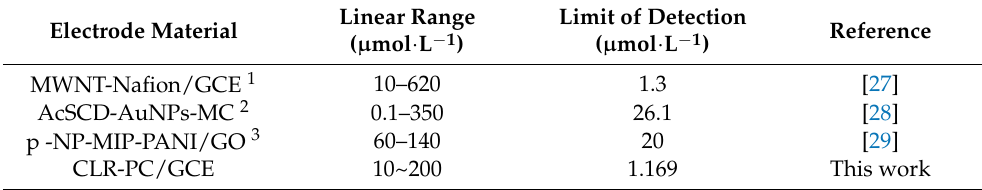
Figure 9. ( a ) DPV responses of CLR-PC/GCE in 0.1 mol · L − 1 PBS (pH = 6.0) containing different concentrations of 4-NP (10–200 µ mol · L − 1 ). Scan rate: 100 mV · s − 1 . ( b ) The calibration plot of peak current versus concentration.